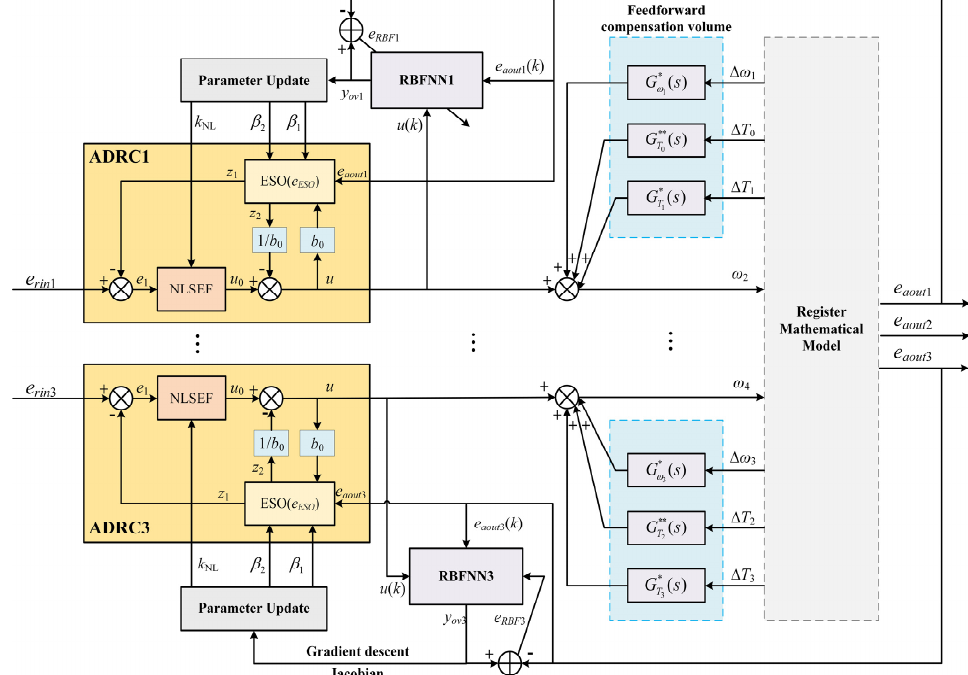
Figure 8. The overall control solution architecture.